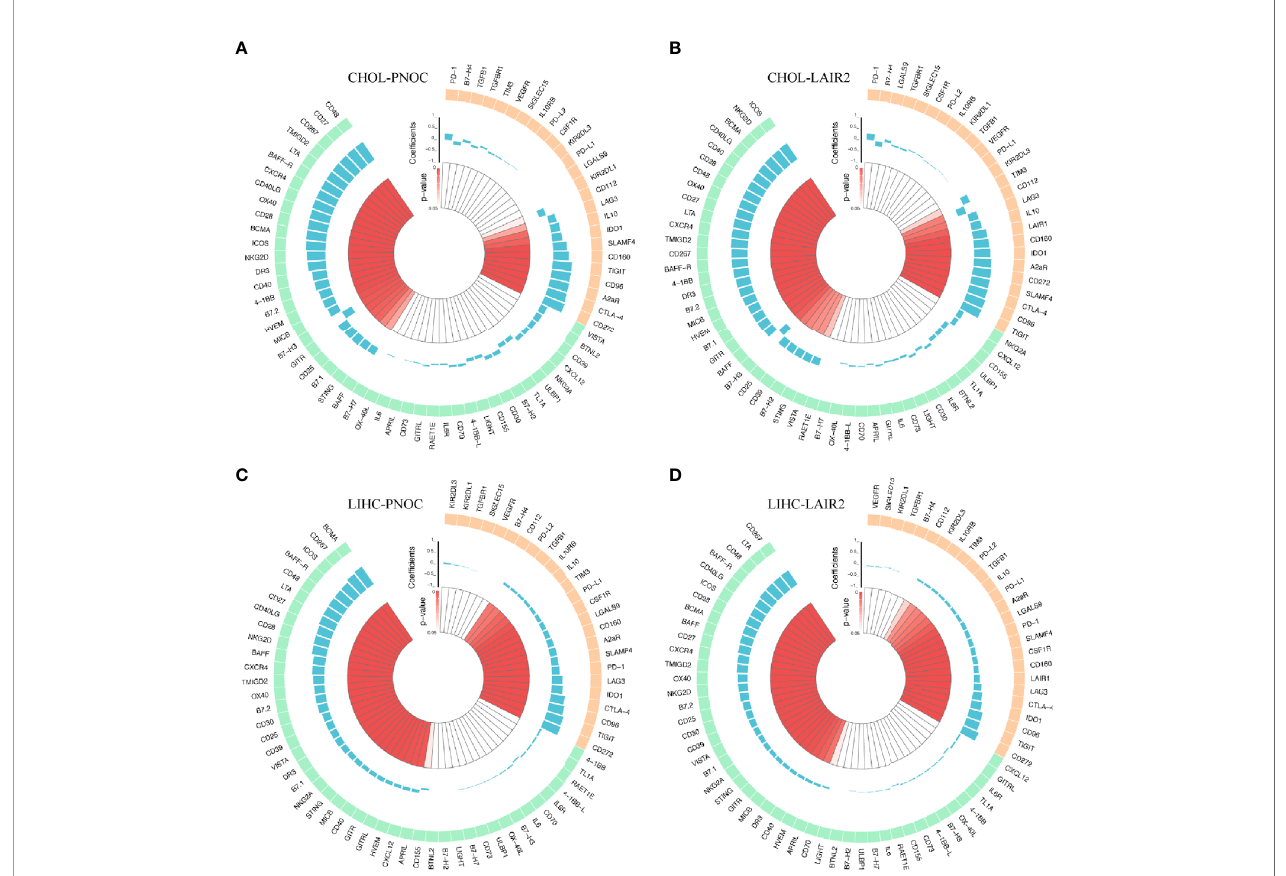
FIGURE 7 | Correlation Between LAIR2, PNOC, and Acknowledged Immune Checkpoints in TCGA CHOL and LIHC Datasets. (A) Correlation between expression of PNOC and immune regulators in CHOL dataset. (B) Correlation between expression of LAIR2 and immune regulators in CHOL dataset. (C) Correlation between expression of PNOC and immune regulators in LIHC dataset. (D) Correlation between expression of LAIR2 and immune regulators in LIHC dataset. (Immune inhibitors were marked with light orange, while immune stimulators were marked with light green. P values over 0.05 were not signi fi cant and were marked with white